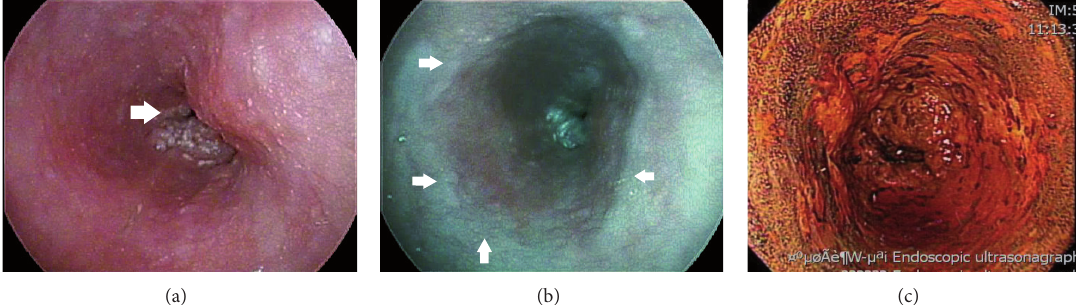
Figure 8: (a) Conventional white-light imaging endoscopy shows an ulcerative mass with lumen obstruction of the esophagus. (b) i-scan (SE 6+, CE 4+, TE-e) discloses reddish discoloration of the adjacent mucosa which is Lugol unstained (c), and the pathology is high-grade intraepithelial